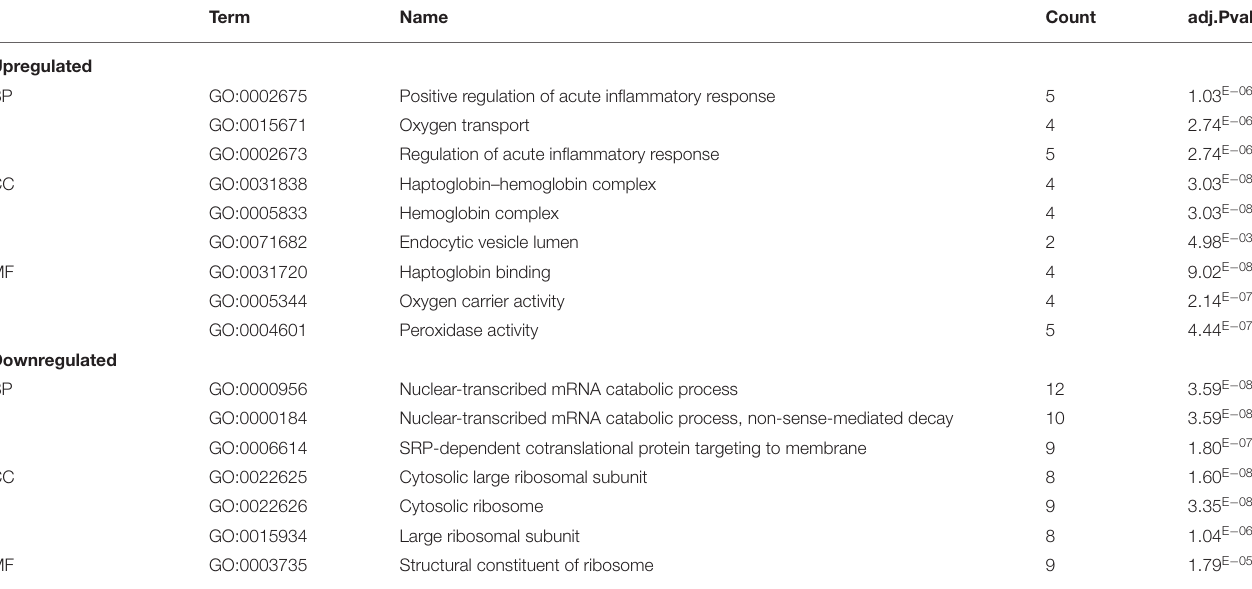
TABLE 1 | The biological process, cellular component, and molecular functions in enriched analysis of differentially expressed genes between AAA and control (top 3 according to adj.P value). Term Name Count adj.Pval